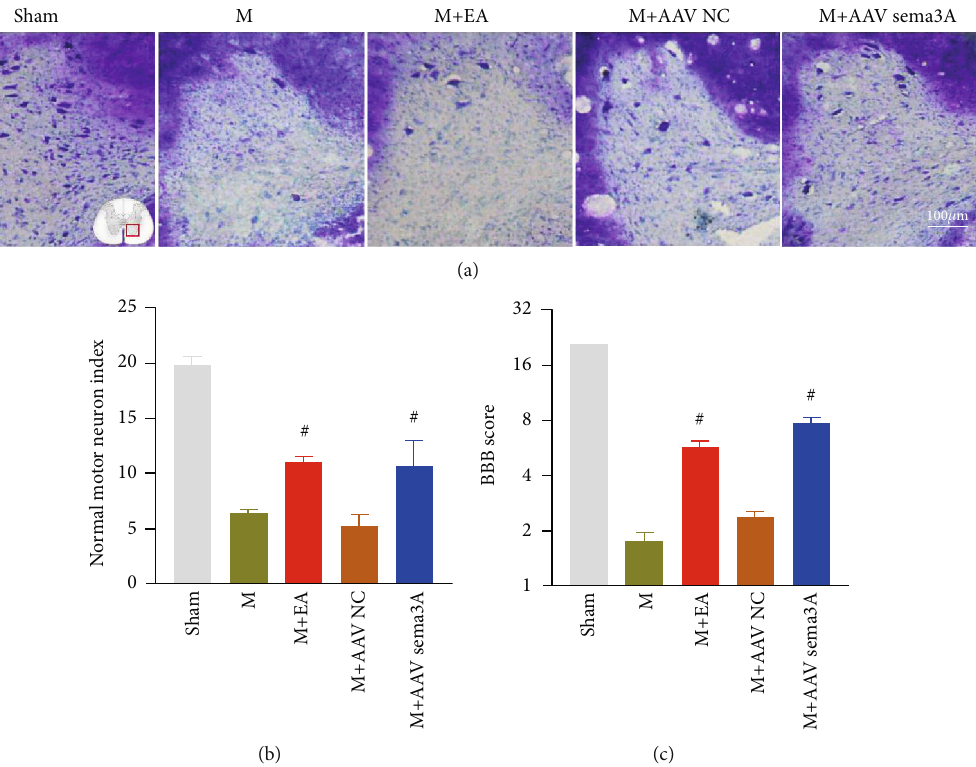
Figure 9: EA or Sema3A knockdown can promote the functional recovery after SCI in rats. (a) The fi gure represents the Nissl staining of the ventral horn of the spinal cord (b) The number of surviving motoneurons in the ventral horn of the spinal cord was quanti fi ed by Nissl staining, compared with the SCI group, # P < 0 : 05 , n = 3 . (c) The motor function score of each group at day 7, compared with the SCI group, # P < 0 : 05 , n = 10 . All data are presented as the mean ± SEM